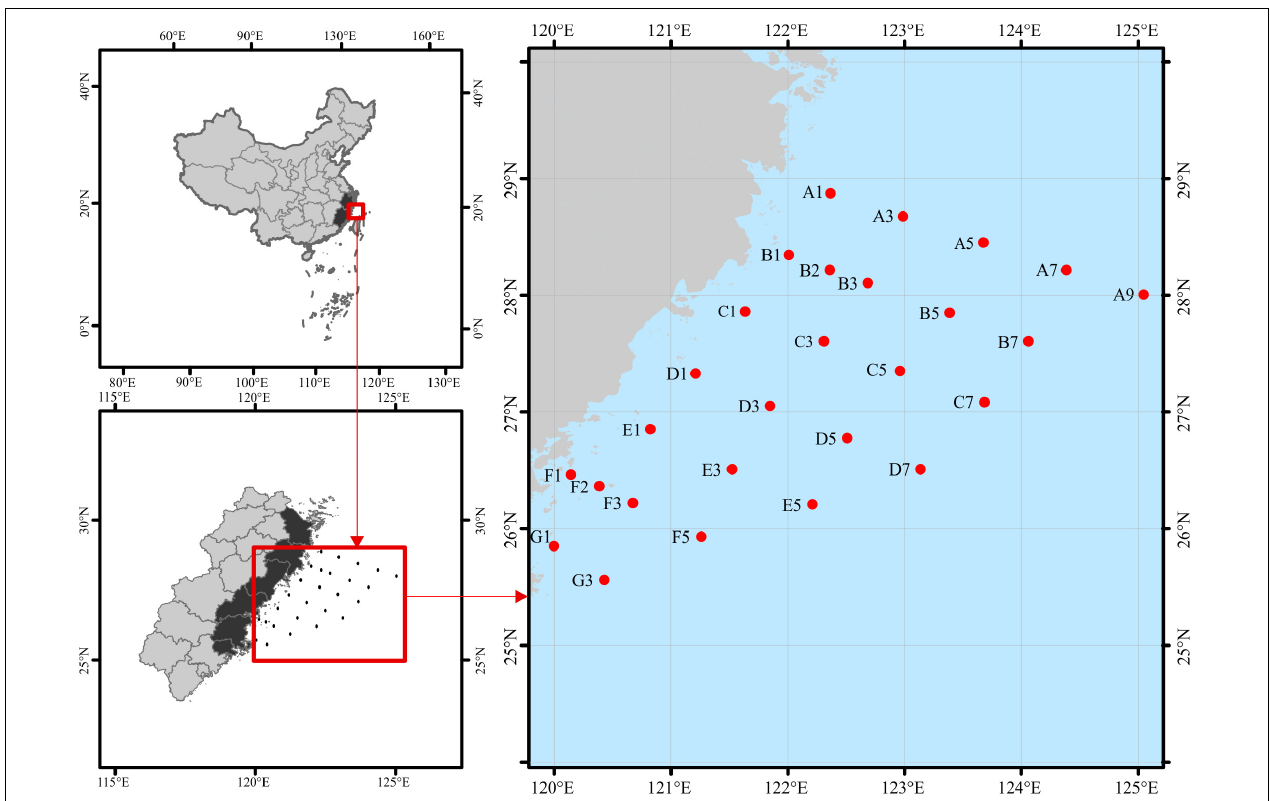
FIGURE 1 | Study area and location of sampling stations in the overwintering ground. To keep the data comparable with future studies, we keep the discontinuous numbers for site names according to the routine-monitoring project. The sampling sites remain the same for both seasons, except for November at B2 and F2 and April at B1 and